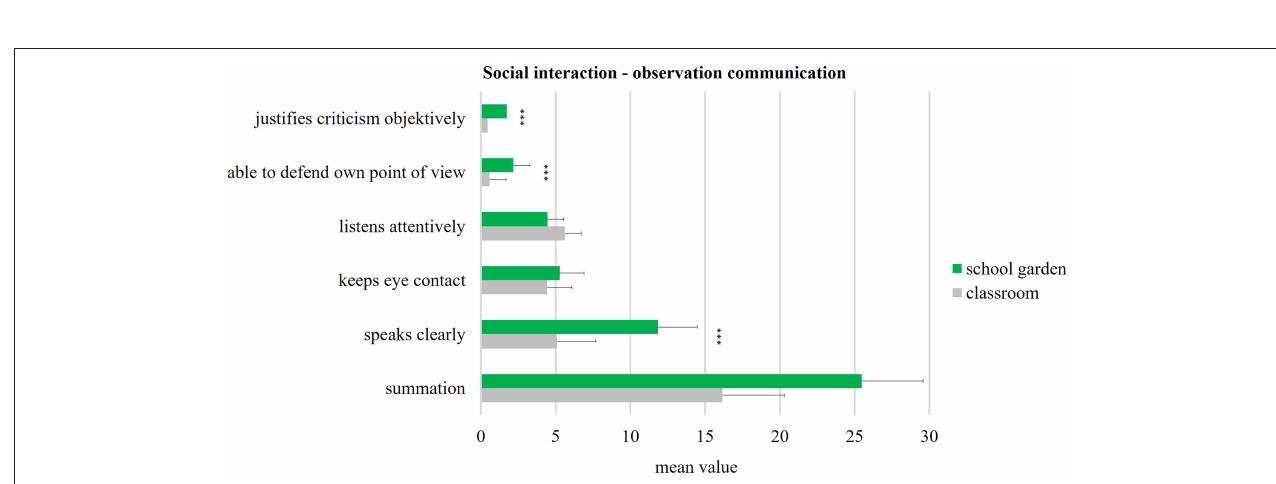
FIGURE 8 | Social interaction - communication (school garden n = 82, classroom n = 68). Significance p different levels (* p < 0.05; ** p < 0.01; *** p < 0.001).